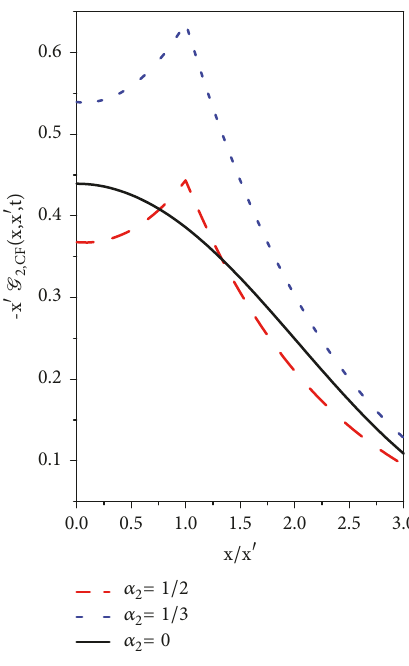
Figure 6: This figure illustrates the behavior of (32) by considering different values of 𝛼 2 . We consider, for simplicity, 𝜏 2,𝐶𝐹 = √𝑥 󸀠2 /𝐷 2 , /𝑥 󸀠 = 1 , 𝜏 = 1 , and 𝛼 = 1/2 , in arbitrary unities. 𝑘𝜏 2,𝐶𝐹 2,𝐶𝐹 2